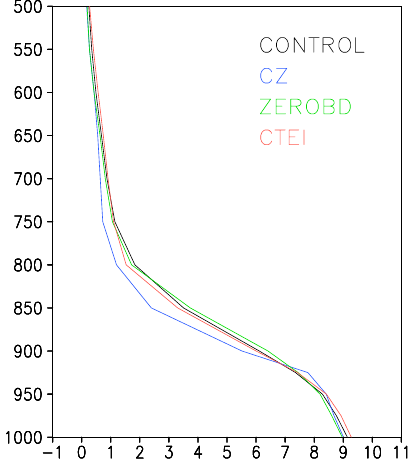
Fig. 15. July 2008 ensemble mean total water profile at (20 ◦ S, 85 ◦ W), vertical coordinate is Pa and horizontal coordinate is